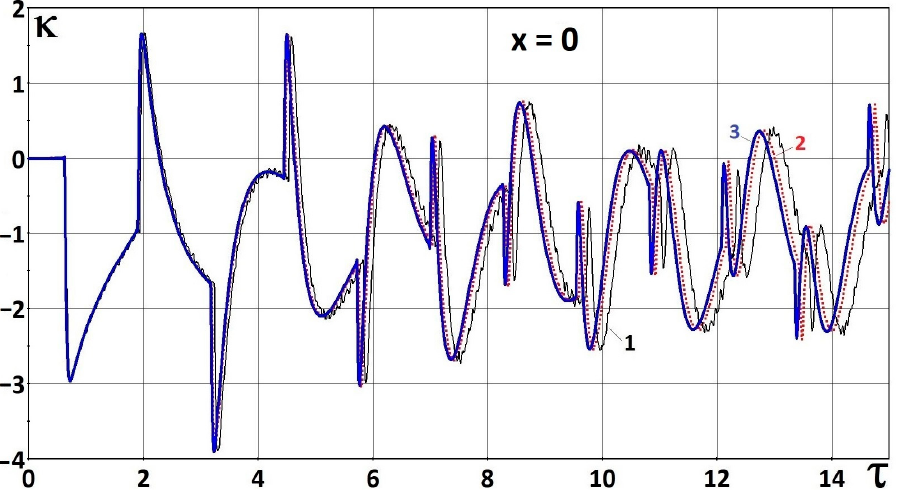
Figure 2. Time history of the relative stress at x = 0 with different number of sub-layers: N = 20, 40, 80 (curves 1, 2 and 3,